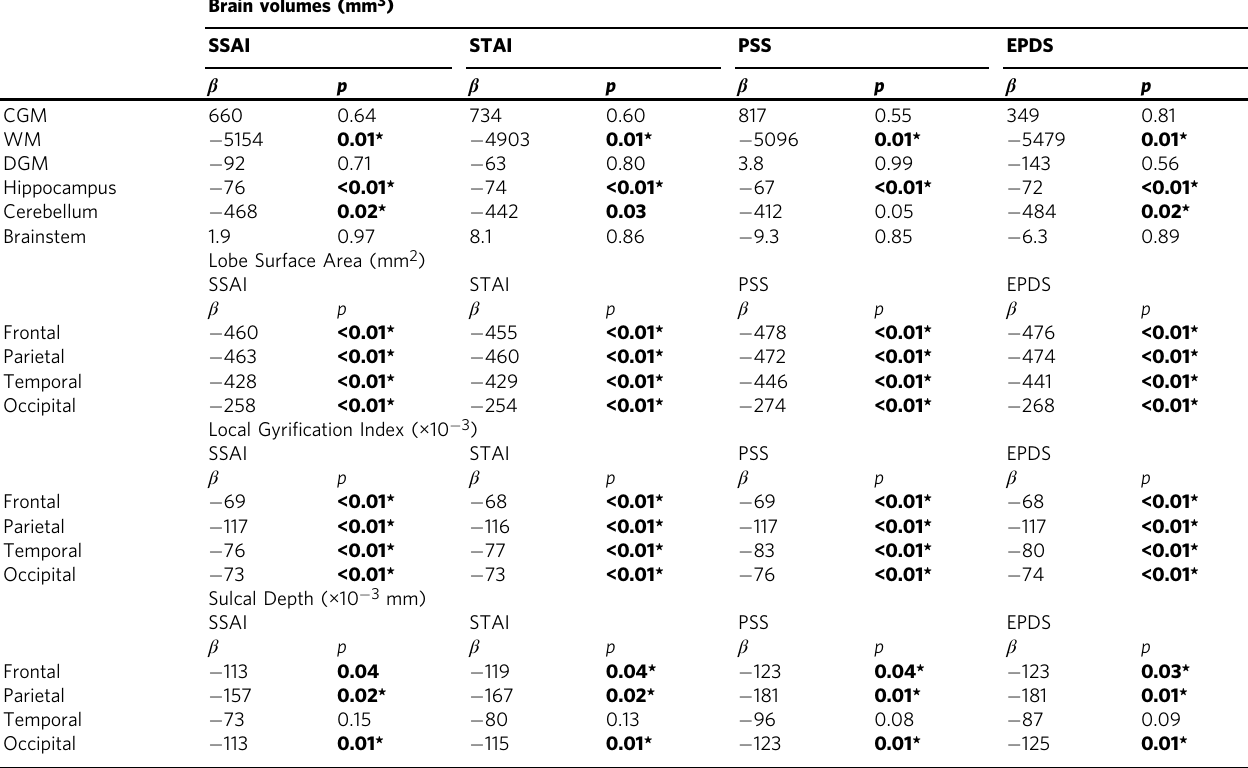
Table 2 The results of the generalized estimating equations (GEEs) for the associations between fetal brain volumes/brain cortical features and cohort status (0: pre-pandemic; 1: pandemic), adjusting for fetal sex, gestational age at MRI (weeks) and each maternal distress